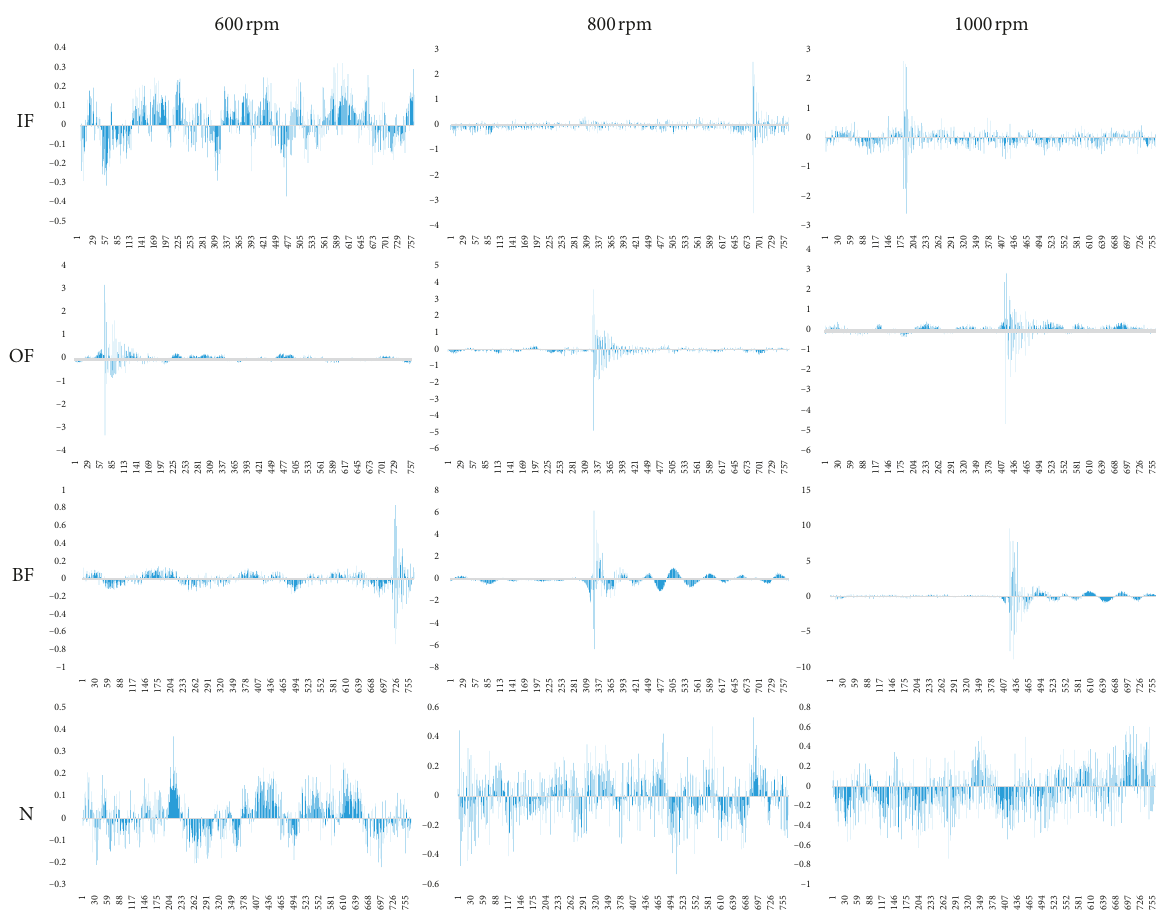
Figure 6: Original waveform of various working conditions. Table 3: Classification accuracy (%) of various